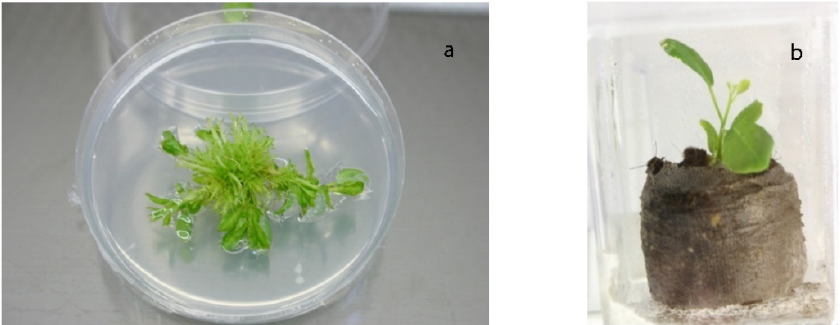
Figure 5. In vitro propagation carried out at the University of Palermo. Experiments on proliferation ( a ) and on the initial phase of ex vitro acclimatization ( b ) .